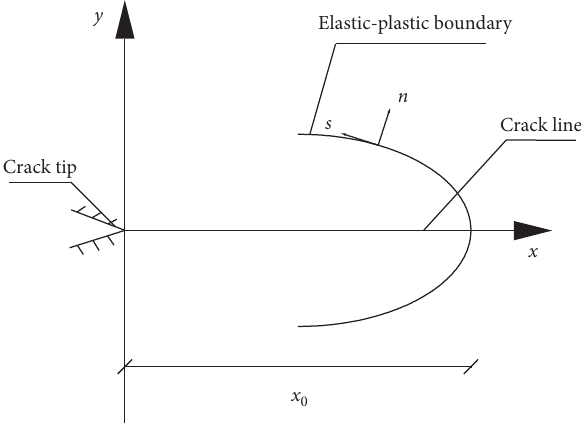
Figure 1: Elastic-plastic boundary near the crack